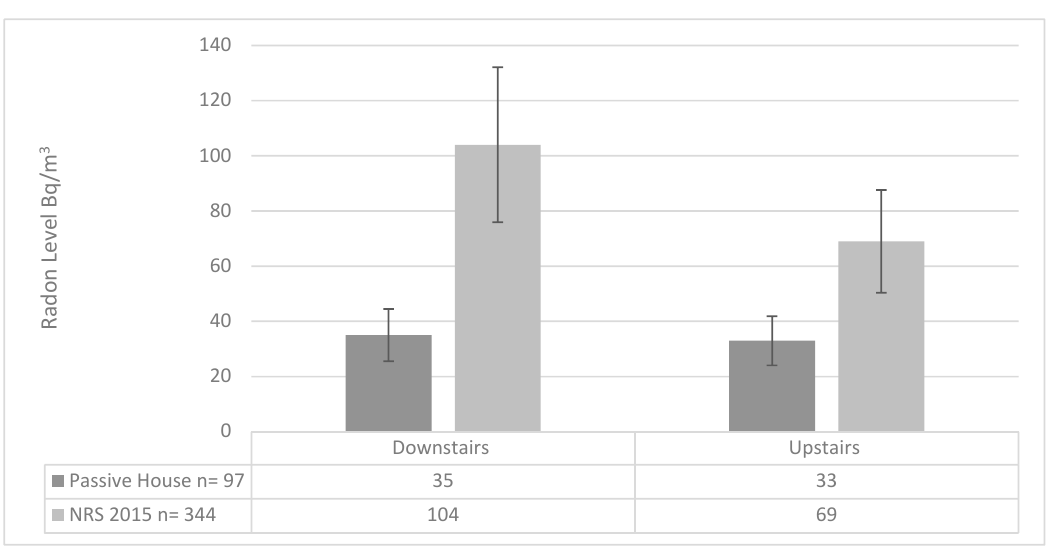
Figure 3. Radon Distribution comparison of data by floor between this study and the NRS 2015.